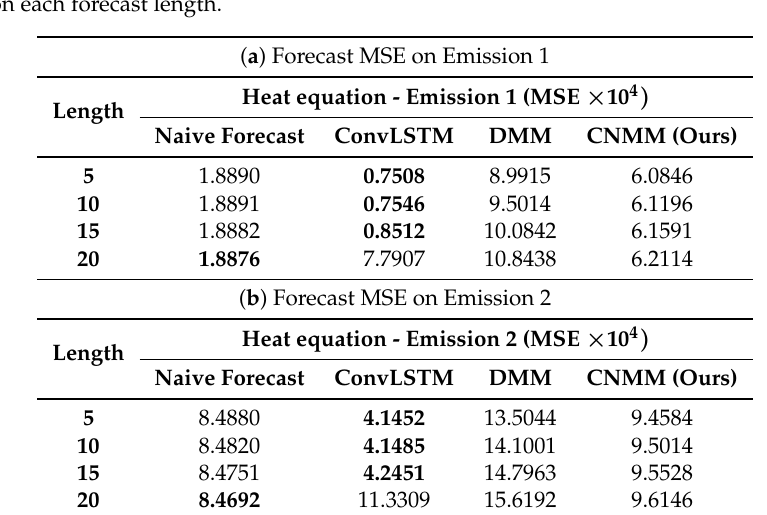
Table 5. Forecast mean squared error (MSE) of the 2D heat equation data experiment on each model, with Emission 1 and Emission 2 denoting each emission condition of the data. The length here shows in how many timesteps the forecast is done on each model. The bold numbers indicate the lowest error achieved on each forecast length.